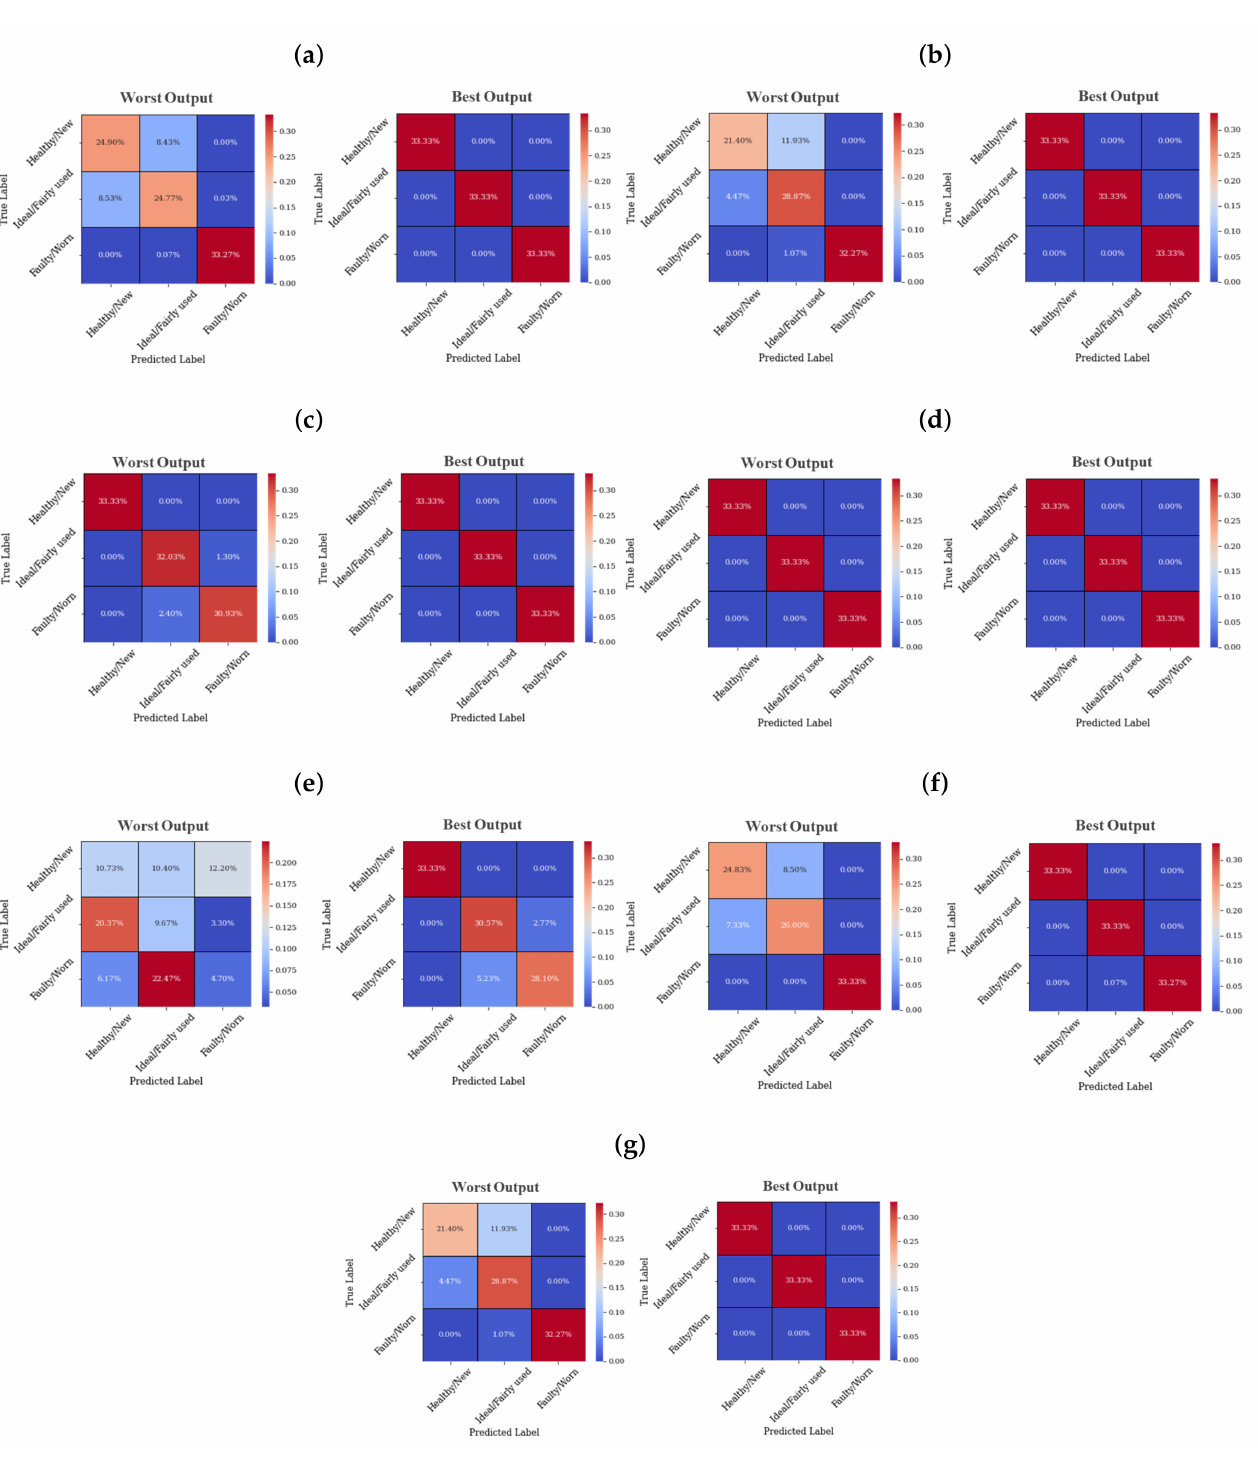
Figure 10. Worst and best Confusion matrices produced by the DL models ( a ) CNN 64, ( b ) CNN 64_64, ( c ) CNN 64_Dense100, ( d ) FCN, ( e ) DNN64, ( f ) DNN128_64, and ( g )